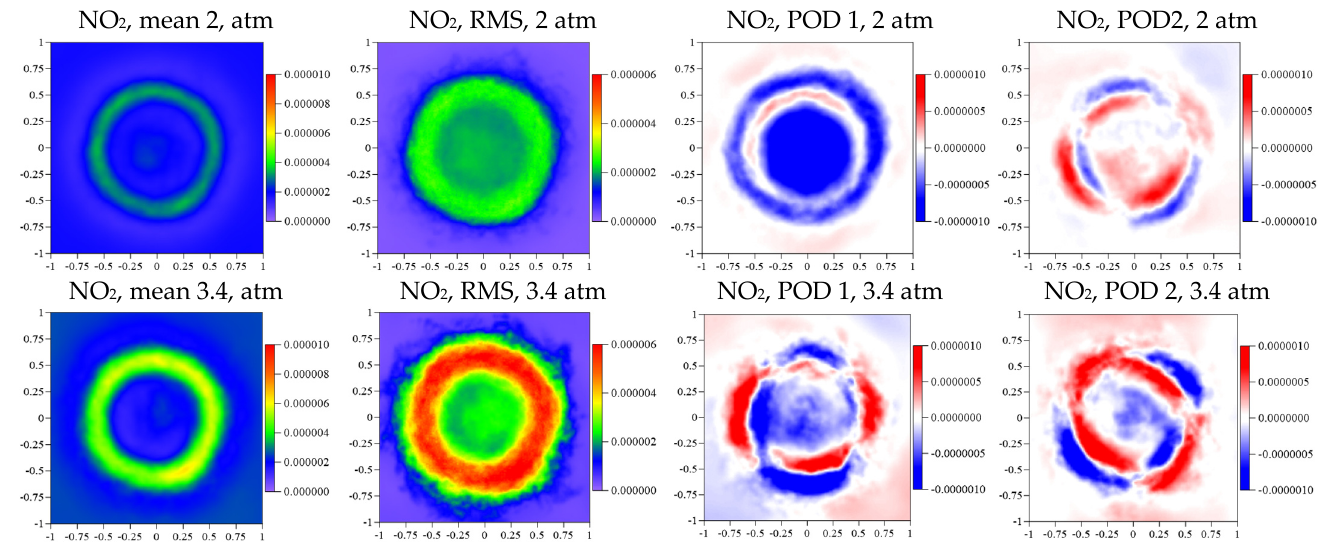
Figure 22. Mean and variation in the NO 2 concentration field and the first and second POD modes.